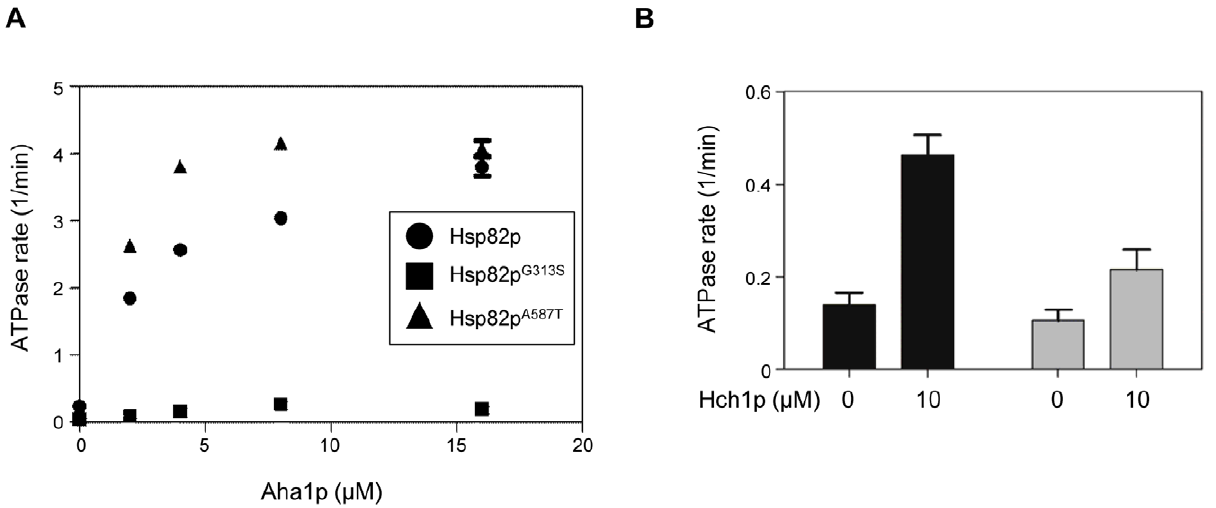
Figure 5. ATPase stimulation of Hsp82p, Hsp82p G313S and Hsp82p A587T . A. Stimulation of the ATPase activity of wildtype Hsp82p (circles), Hsp82p G313S (squares), and Hsp82p A587T (triangles) by increasing concentrations of Aha1p. B. Stimulation of the ATPase activity of wildtype Hsp82p (black bars), and Hsp82p A587T (grey bars) by Hch1p. ATPase rate shown in m M ATP hydrolyzed per minute per m M of enzyme (1/min). Reactions contained 2 m M Hsp82p and indicated concentration of Aha1p or Hch1p.